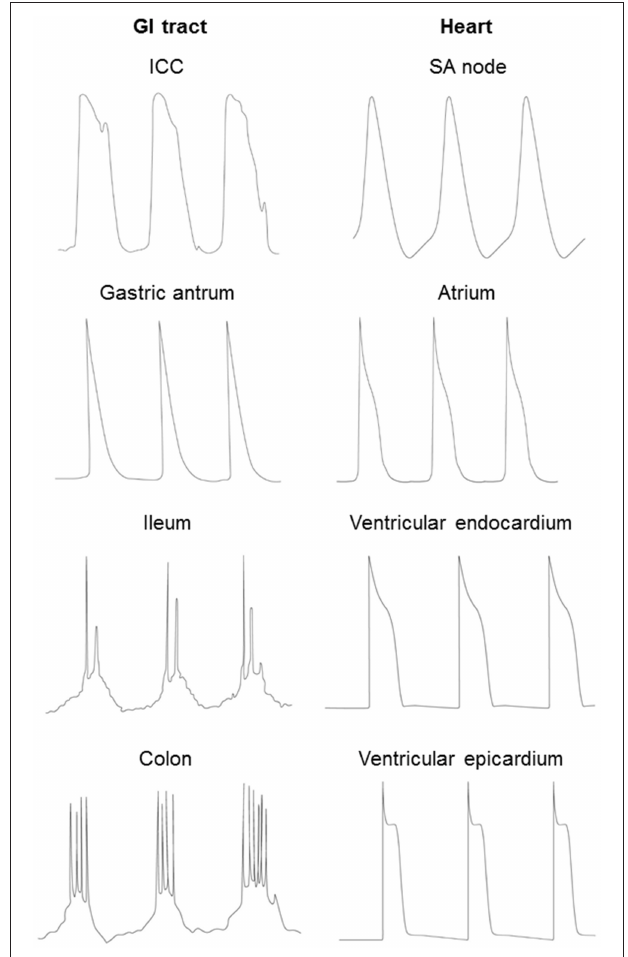
FIGURE 2 | Different waveforms of the cardiac AP and GI slow wave in different cell